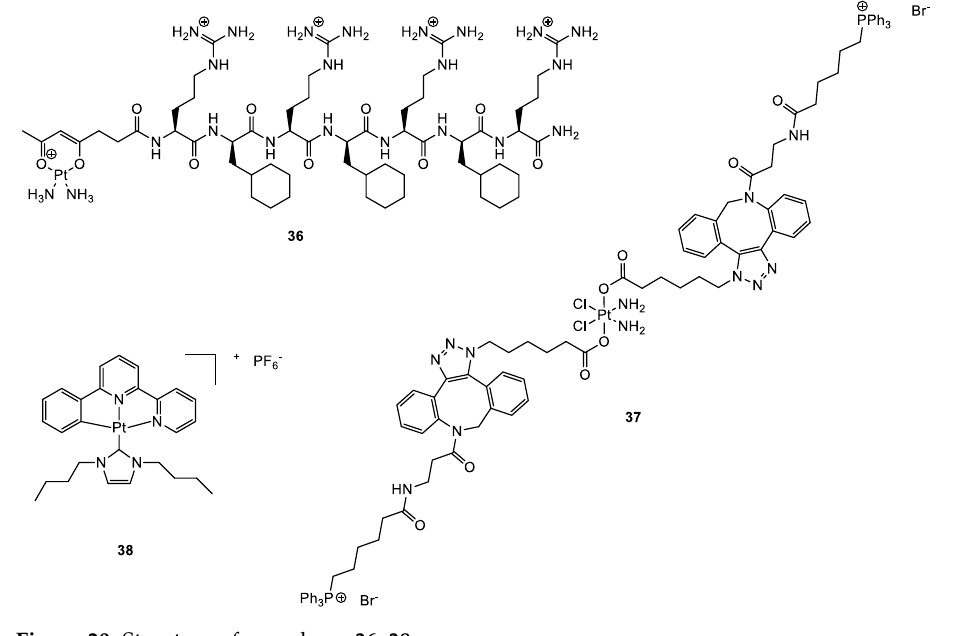
Molecules 2023 , 27 , x FOR PEER REVIEW Figure 20. Structure of complexes 36 – 38 . Figure 20. Structure of complexes 36 – 38 .